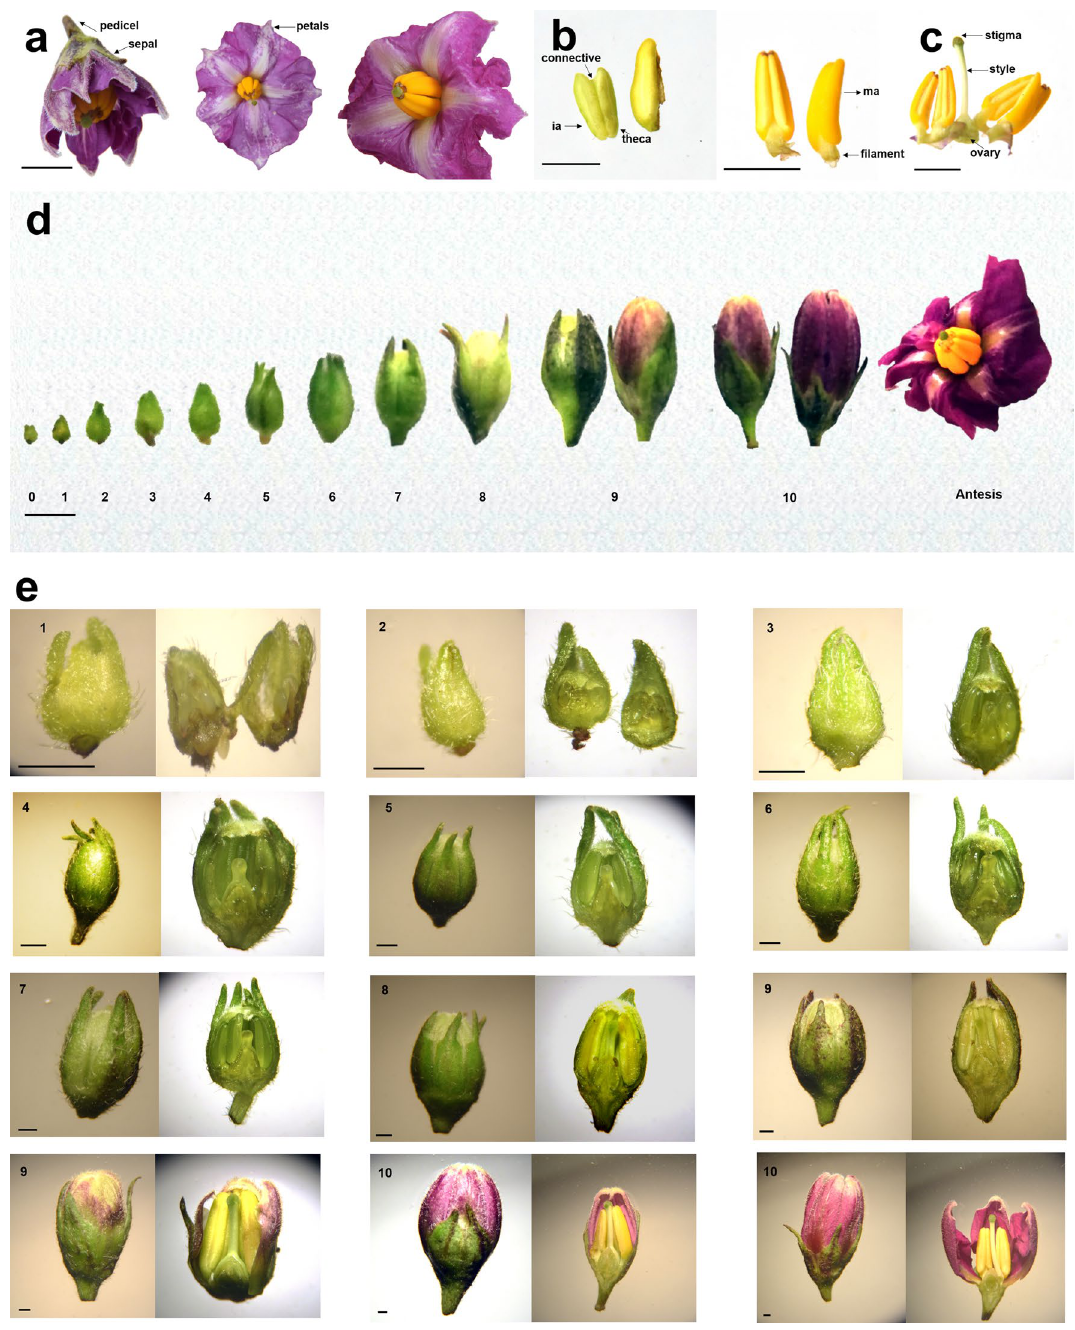
Figure 1. Buds and flowers of diploid yellow potato ( Solanum tuberosum Grupo Phureja) cultivar criolla Colombia (scale bar a–d = 5 mm; e = 1 mm). Arabic numerals 1 to 10 represent anther developmental stages. Representative images of: ( a) Perfect flowers with sepals, petals, anther ring and stigma. ( b ) Anthers. ( c ) Androecium and Gynoecium. ( d ) Development of buds from state 0 to 10. (e) Full bud and its cross section developing from state 0 to 10. ia immature anther, ma mature anther. Photographs and images created by the